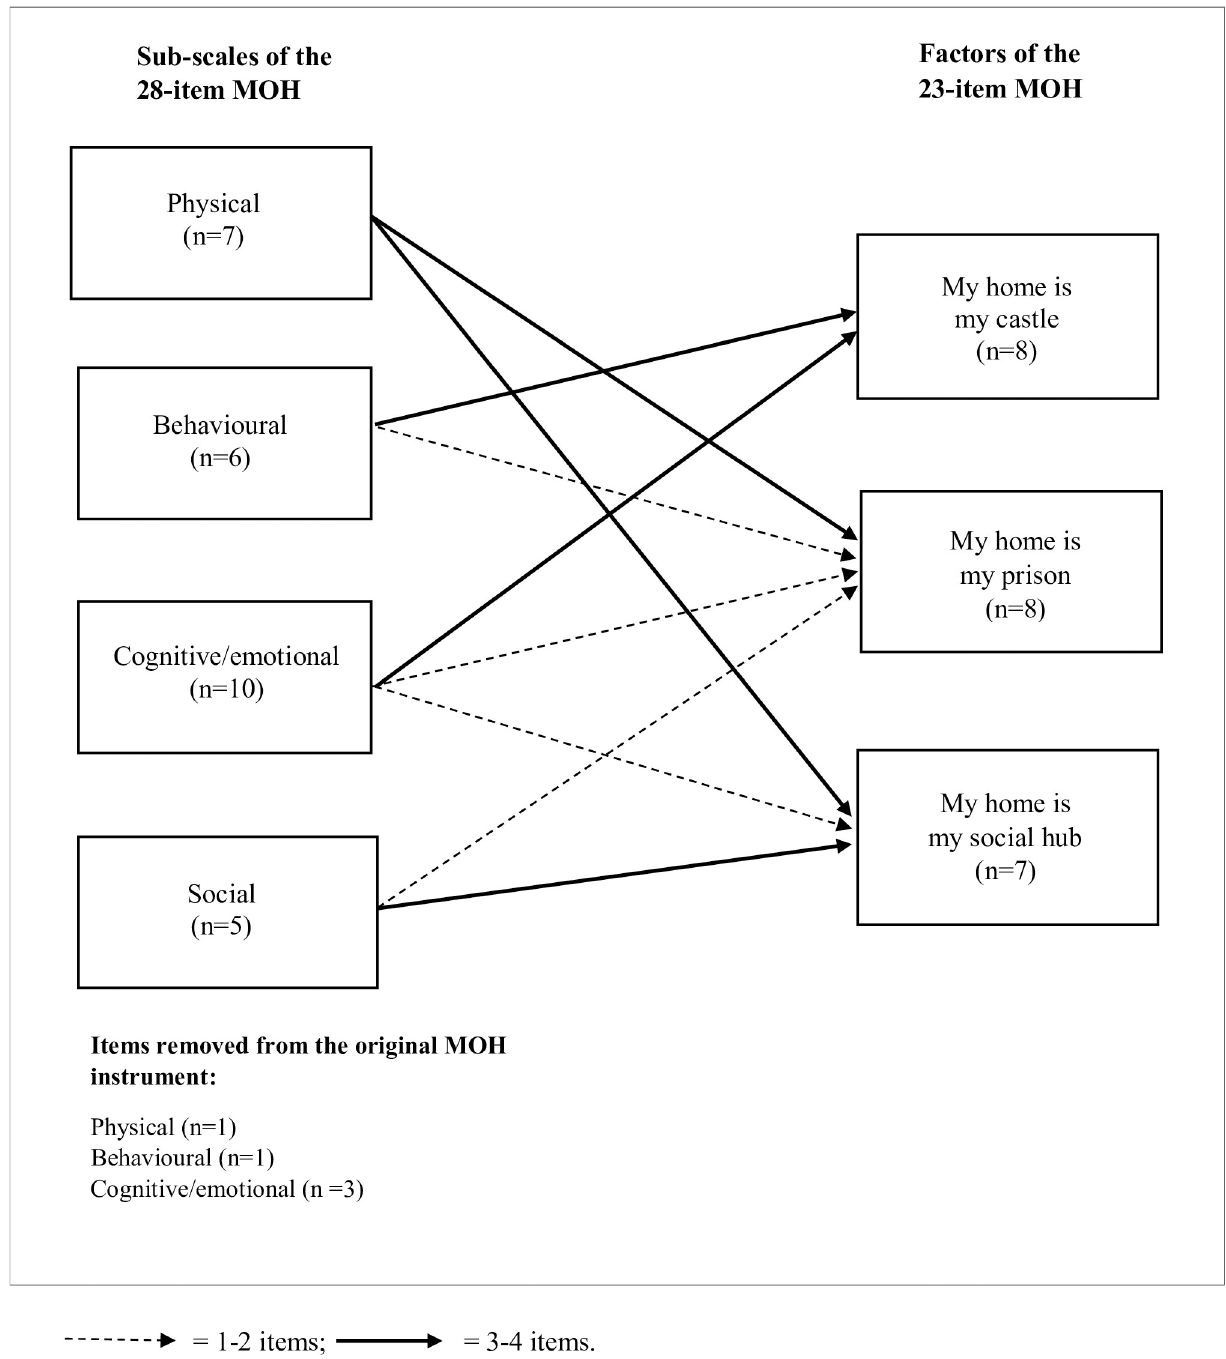
Fig 1. Items movement from the sub-scales of the 28-item version of MOH, to the new factor solution.